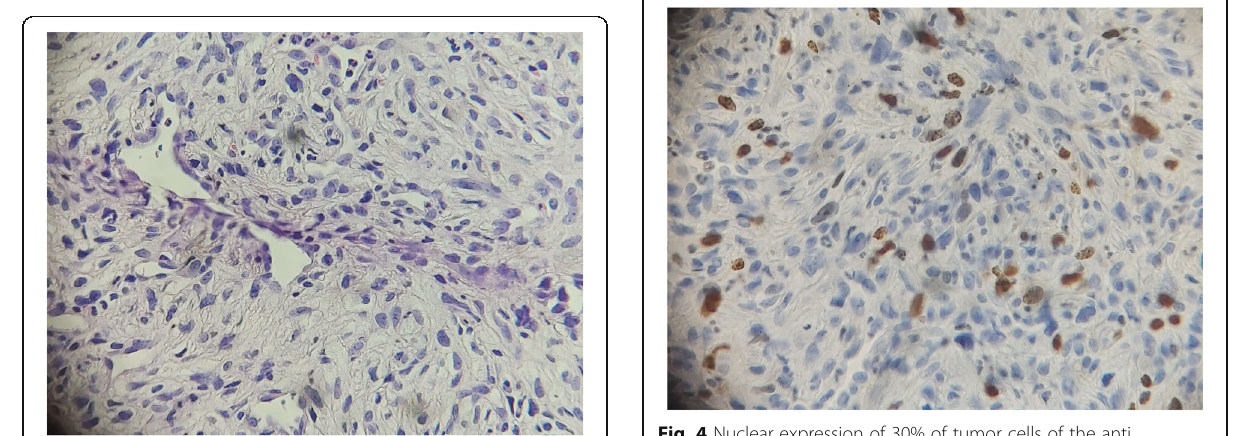
Fig. 2 storiform organization of HEx40 tumor proliferation